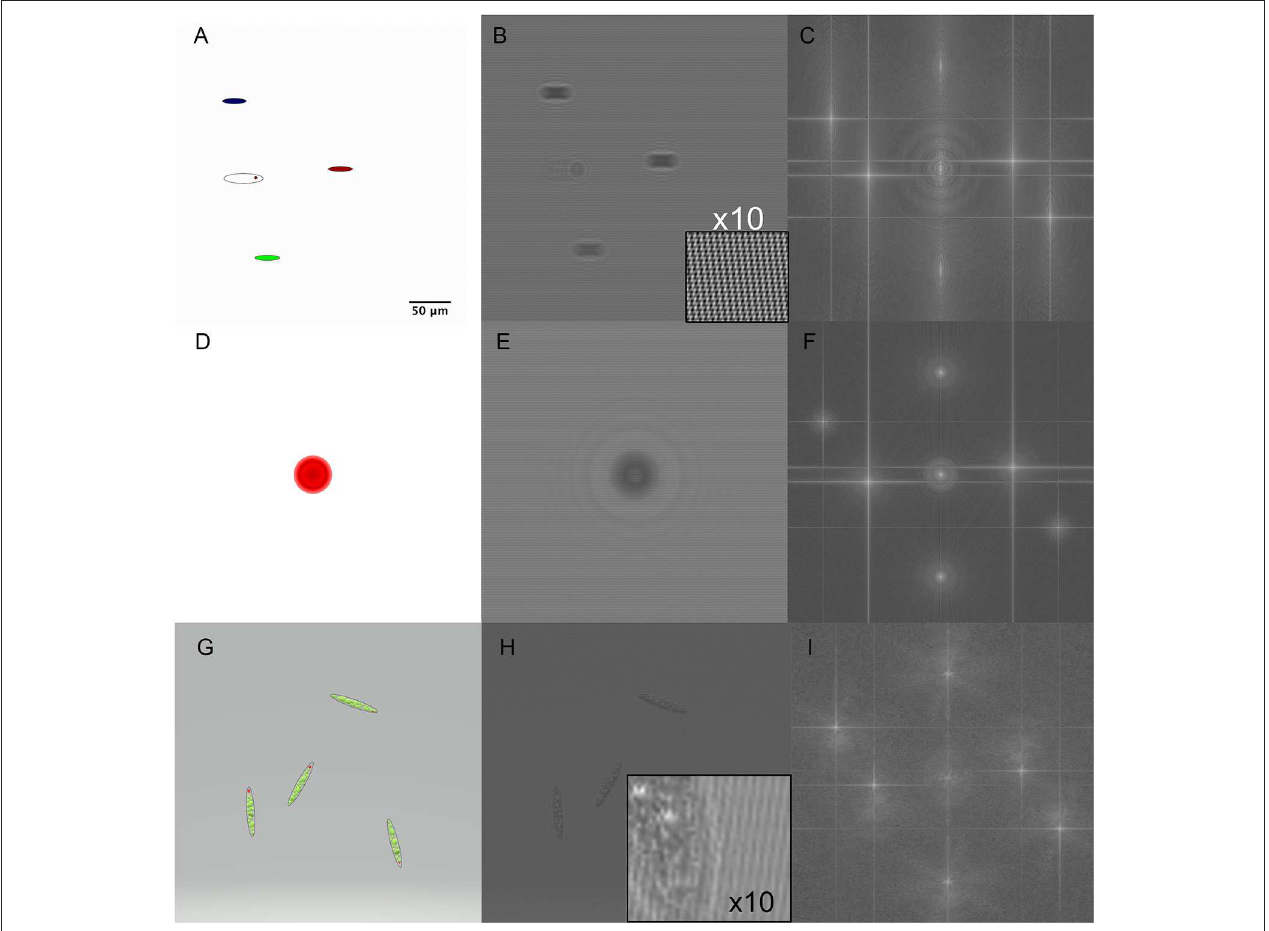
FIGURE 3 | Simulated holograms of RGB pure amplitude objects. Scale bar applies to all panels. (A) Ellipses corresponding to approximate Euglena dimensions. (B) 3-wavelength hologram simulation with the magnified inset showing the 3 sets of fringes rotated with respect to each other. (C) Fourier transform of the hologram showing the actual and virtual images in each wavelength. (D) A red sphere of sufficient depth to cause phase wrapping (OPL > λ ). (E) Hologram of the red sphere. (F) Fourier transform of sphere hologram. (G) A simulated RGB Euglena showing green chloroplasts and a red eyespot. (H) Simulated hologram of model Euglena with inset showing size of features relative to fringe spacing. (I) Fourier transform of Euglena hologram. filled with dH 2 O and provide the reference beams. All 4